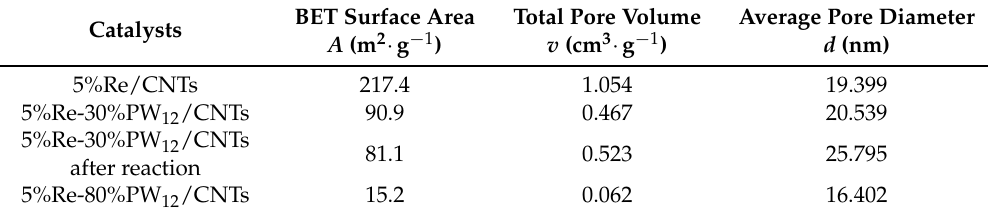
Table 4. Textural properties of the catalysts.